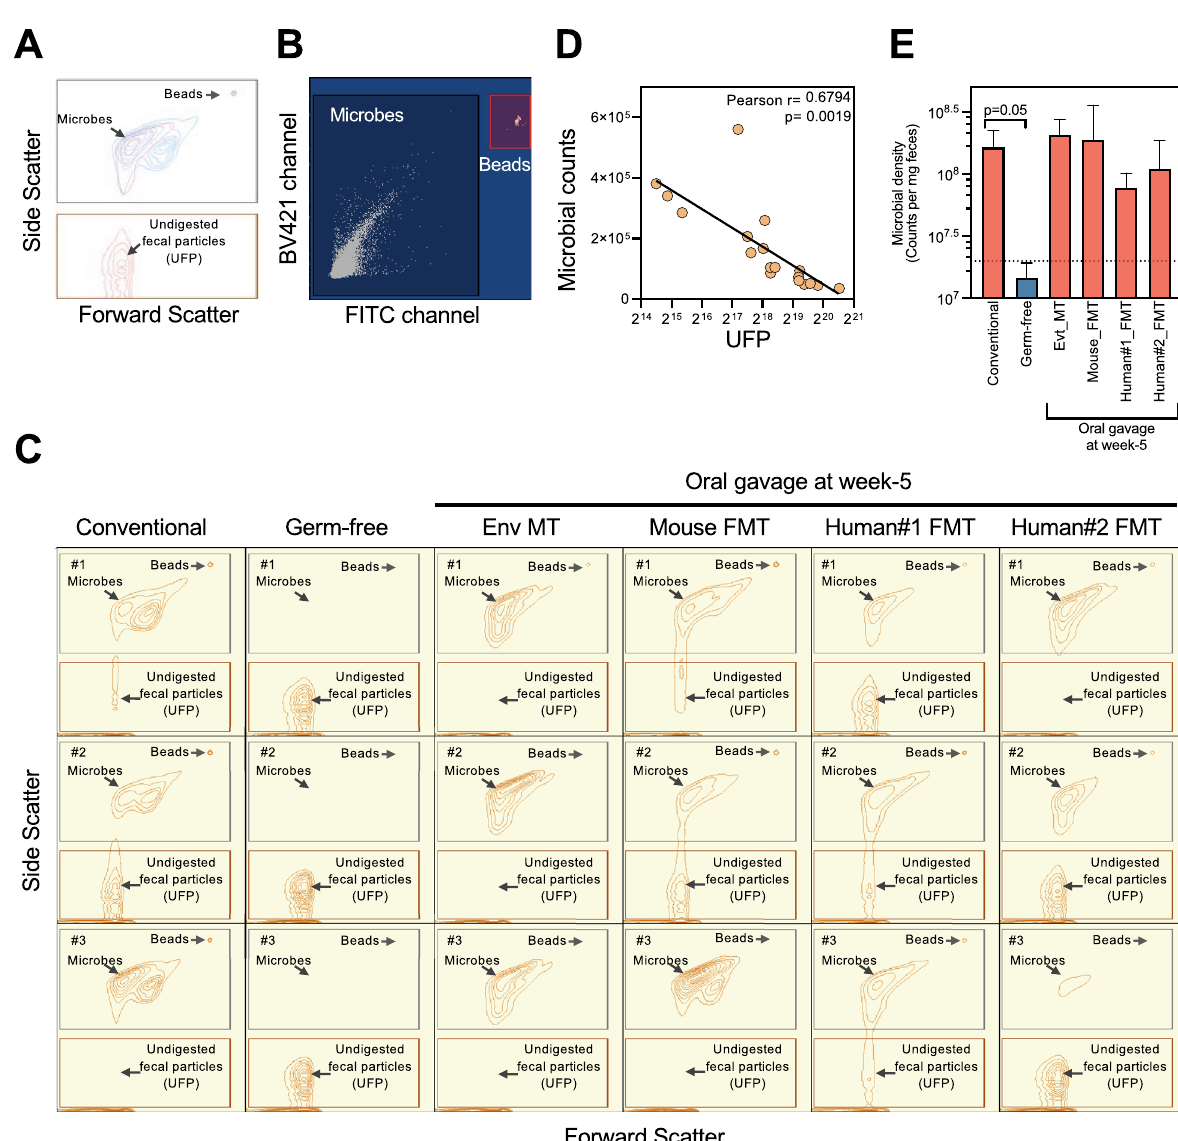
Figure 3. Quantitative flow cytometry analysis of fecal microbial dynamics. ( A ) Overlayed contour FACS plots of conventional and human FMT samples showing 2 distinct clusters of microbial flora in the upper half of the plot. The human FMT group shows presence of only 1 of the 2 clusters seen in the conventional mice samples. Arrows indicate microbial presence, UFP and beads. ( B) Representation of gates drawn for microorganisms and counting beads using flow cytometry analysis. ( C ) Flow cytometry plots of 3 fecal samples from each group depicting lack of distinct microbial cluster and enrichment of fecal UFP in germ-free feces. These plots also highlight differing levels of microbial and UFP particles in feces. It is notable that even in germ-free feces, low background counts are consistently observed which may be due to particles introduced from feces and sample processing steps. ( D ) Pearson’s (non-linear regression) correlation between the fecal UFP and the fecal microbial counts for all fecal samples. The outlier in data could represent occasional disrupted relationship between the microbial density and UFP. ( E ) Absolute microbial counts per mg